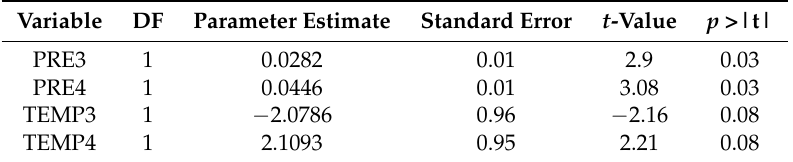
Table A1. Regression Model taken into account observations from 2015 to 2017 (3 years). Variable DF Parameter Estimate Standard